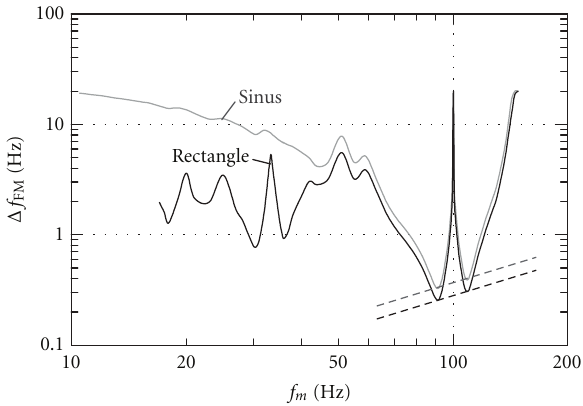
Figure 14: Δ f FM = f ( f m , P st = 1 = const) characteristic for FM modulation with sinusoidal and rectangular